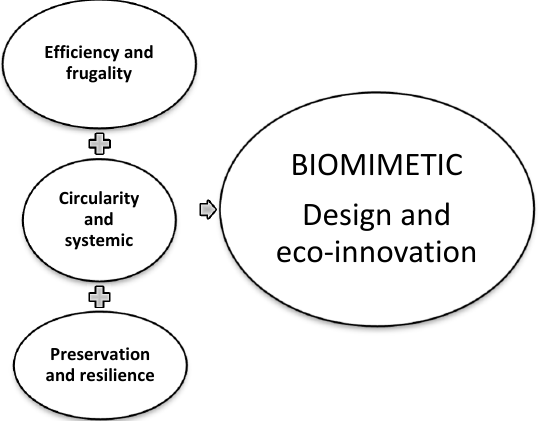
Figure 2. Dimensions proposed for grouping the principles of nature (“Life’s Principles”) used in biomimetic design.